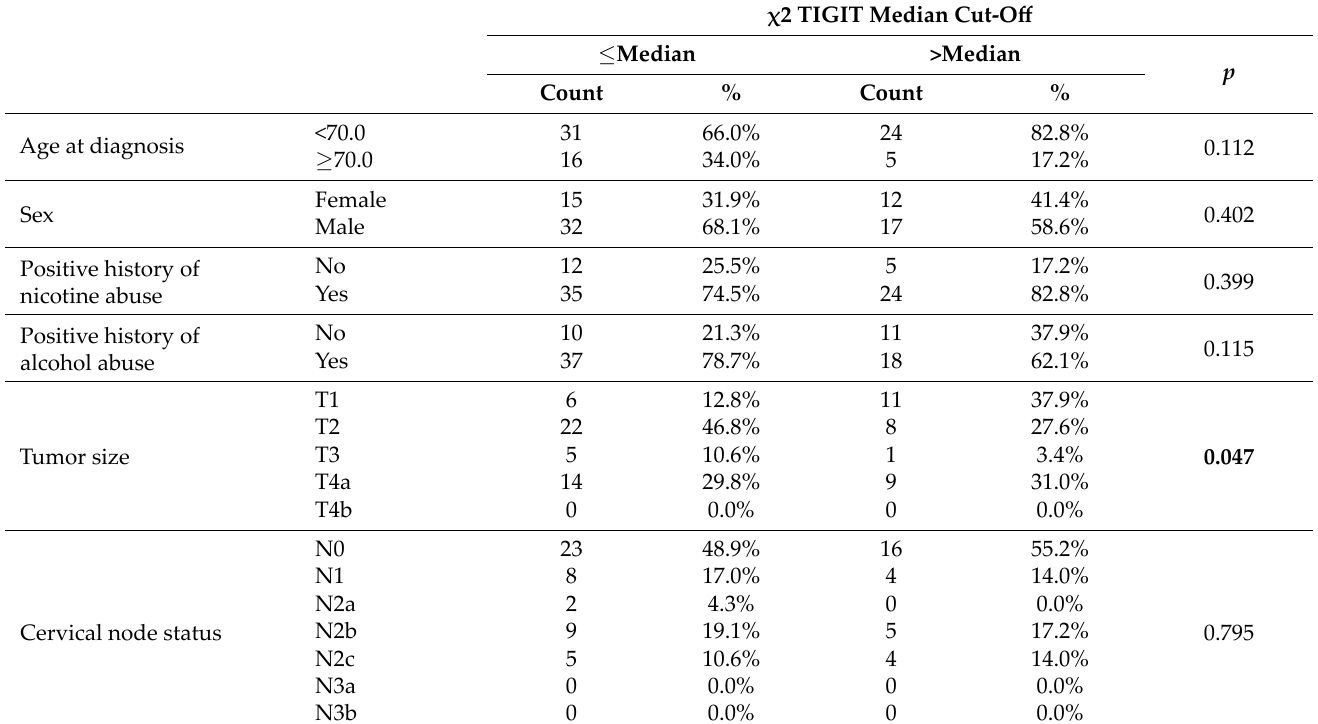
Figure 3. Immunohistochemical TIGIT expression in OSCC TMA cohort. Representative histopathology (hematoxylin & eosin, H&E) and CD3/TIGIT immunohistochemistry (IHC), respectively, of two cases of oral squamous cell carcinoma (OSCC). ( a ) (First row) represents an OSCC with stromal and intraepithelial CD3 and TIGIT double − positive T cells (magnification 400X each, 1000X for the inset). ( b ) (Second row) represents an OSCC with stromal and intraepithelial CD3+ T cells that do not express TIGIT (400X). Table 2. Patients’ clinicopathological characteristics according to TIGIT expression of CD3+ cells (median cutoff; n = 76).